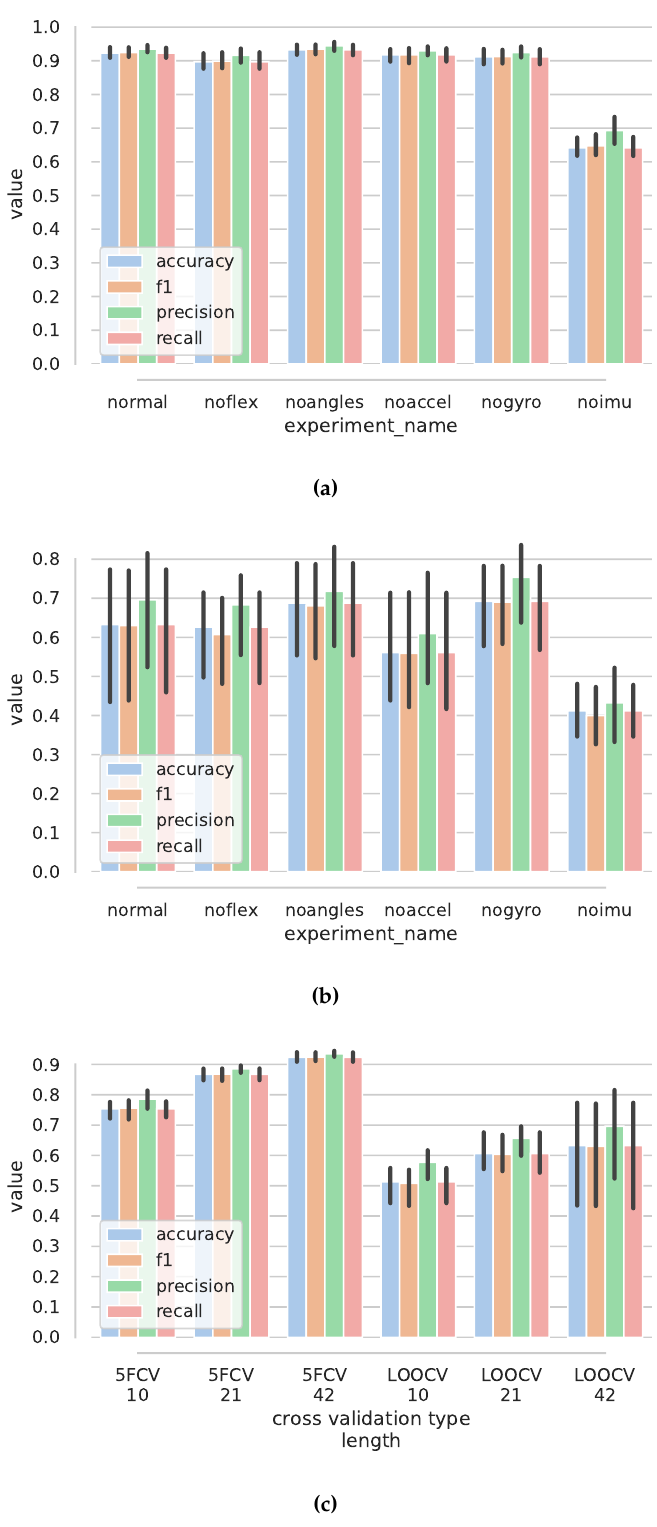
Figure 13. Results for exercise classification using convolutional neural networks. ( a ) Bar plots of exercise classification values for five-fold cross validation. N s = 42. ( b ) Bar plots of exercise classification values for leave-one-out cross validation. N s = 42. ( c ) Exercise classification results for five-fold cross validation (5FCV) and leave-one-out cross validation (LOOCV) for different length of time window N s and using all features